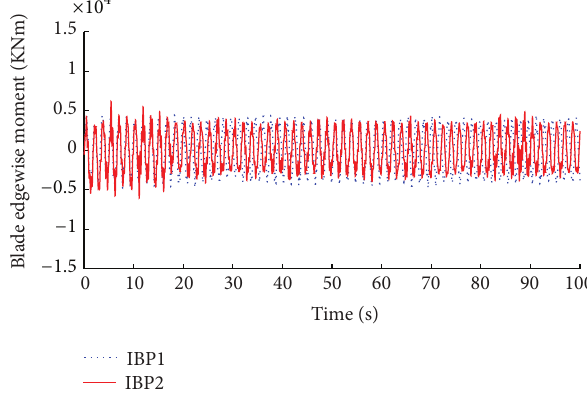
Figure 8: Comparison of power tracking.